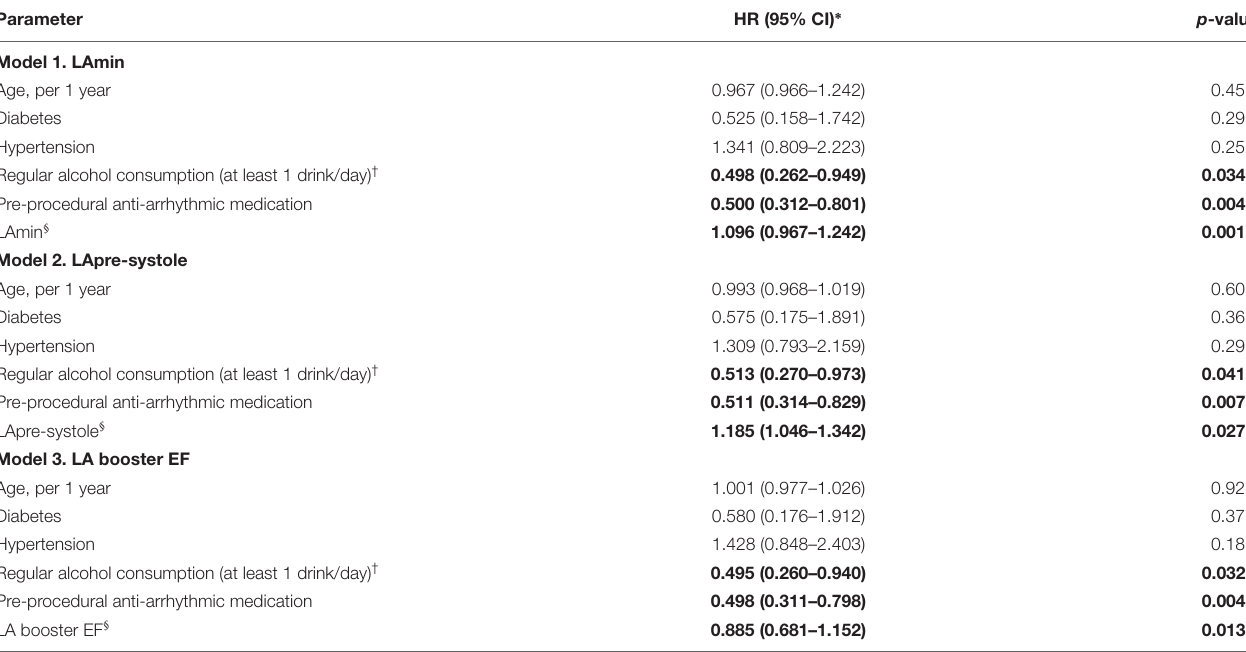
TABLE 6 | Multivariable models for associations of Z-scores for left atrial CMR parameters with the primary clinical outcome in overall cohort (both